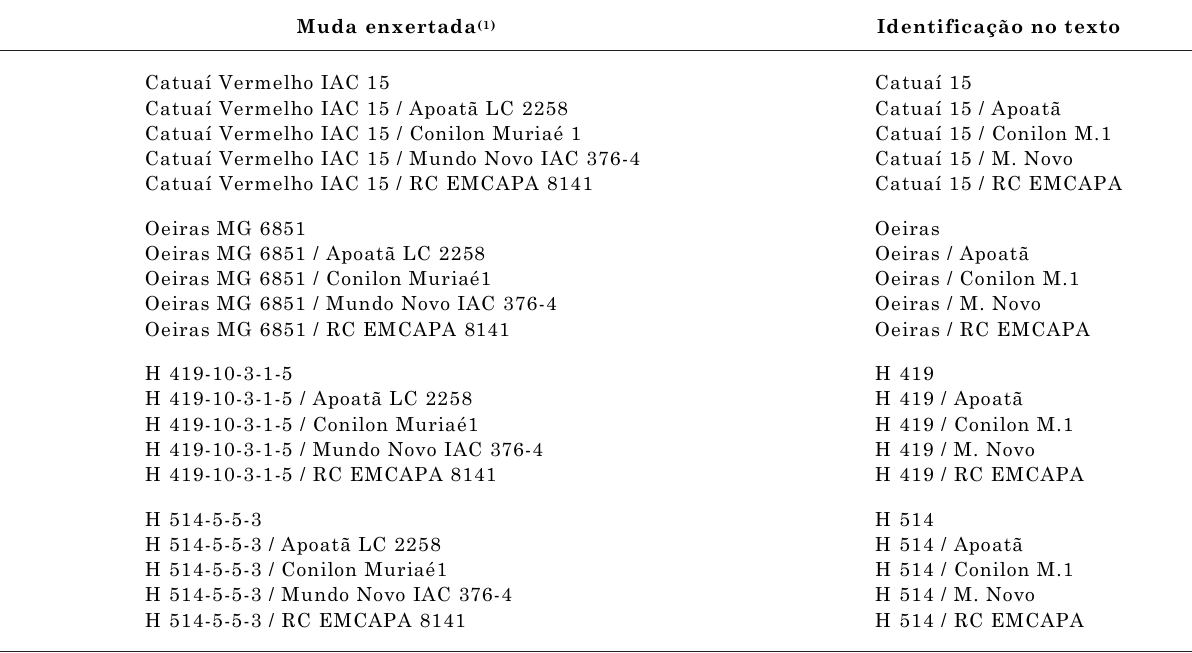
Quadro 1. Relação das combinações de enxertia em mudas de genótipos de